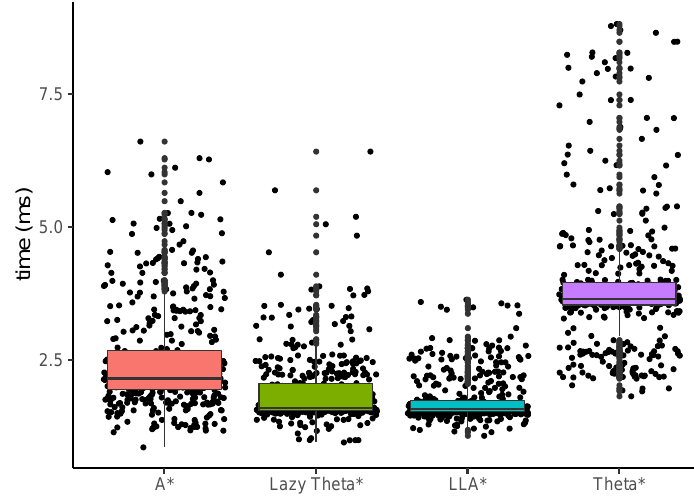
Figure 10. The execution time of 500 times of the maze test #1 using the four planners. LLA* is the fastest among these planners on average.